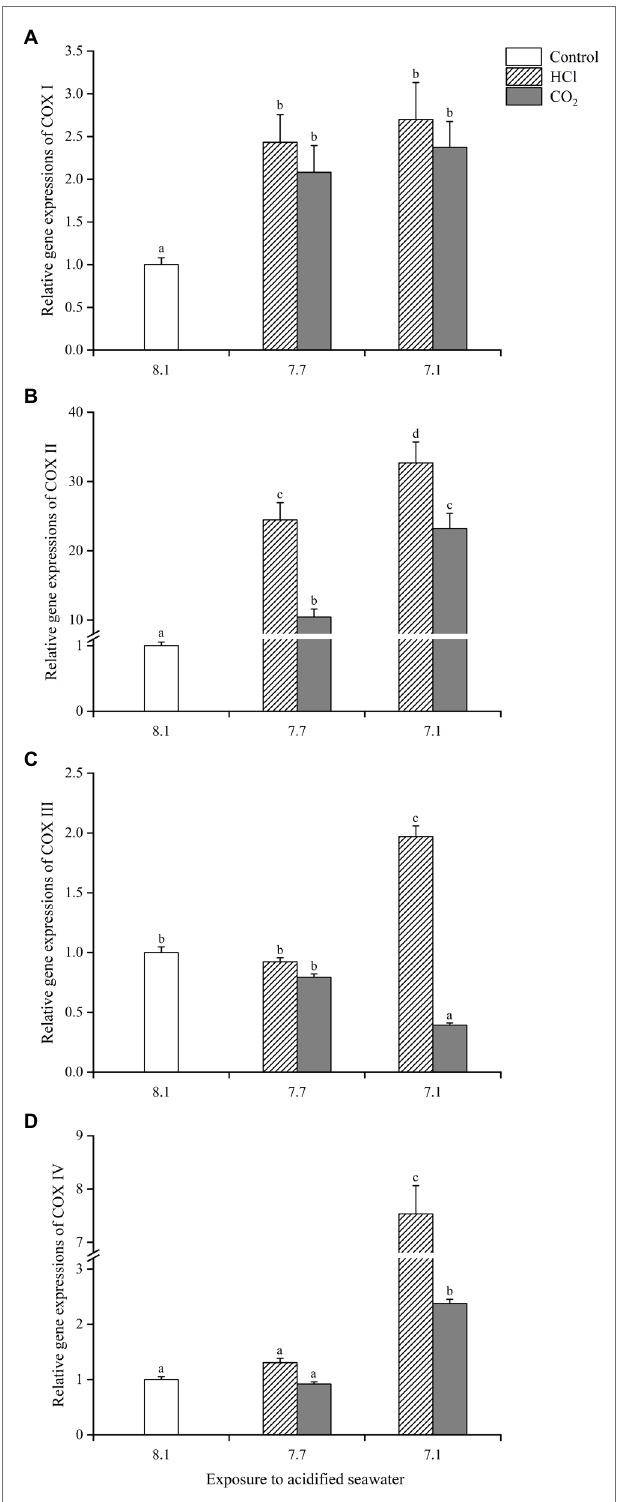
FIGURE 5 | The expression profiles of four cytochrome C oxidases (COXs) [ (A) : COX I; (B) : COX II; (C) : COX III; (D) : COX IV] in gills of M. edulis under seawater acidification induced by HCl addition and CO 2 enrichment. Data were expressed as means ± SD ( n = 6). Different letters represent significant differences among experimental groups ( p <